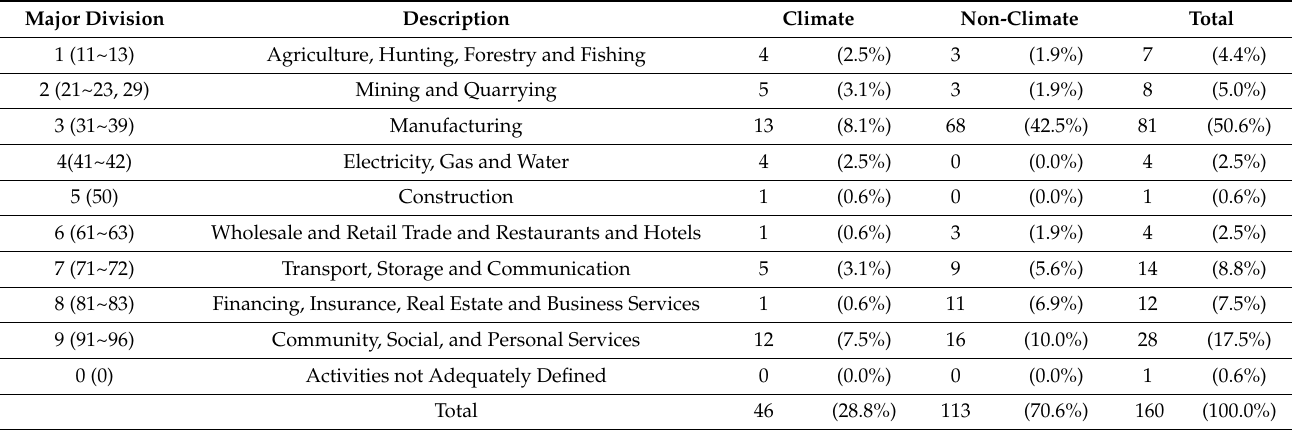
Table 2. Climate Change Classification based on ISIC